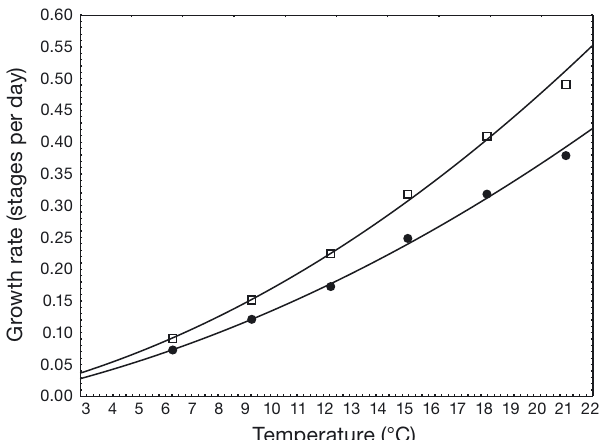
Fig. 3. Mean daily growth rate (rM) for male ( h ) and female ( d ) Lepeophtheirus salmonis vs. temperature ( T) over the 5 post infection development stages calculated based on indi- vidual regression lines for each temperature group. The lines are the model predictions of the mean daily growth rate as a function of temperature ( T) for males and females respectively given by the term rM( T) = bT 2 + cT + d in the overall growth model MnM( T) = a + rM( T) dpi. The values of the constants a , b , c and d are listed in Table